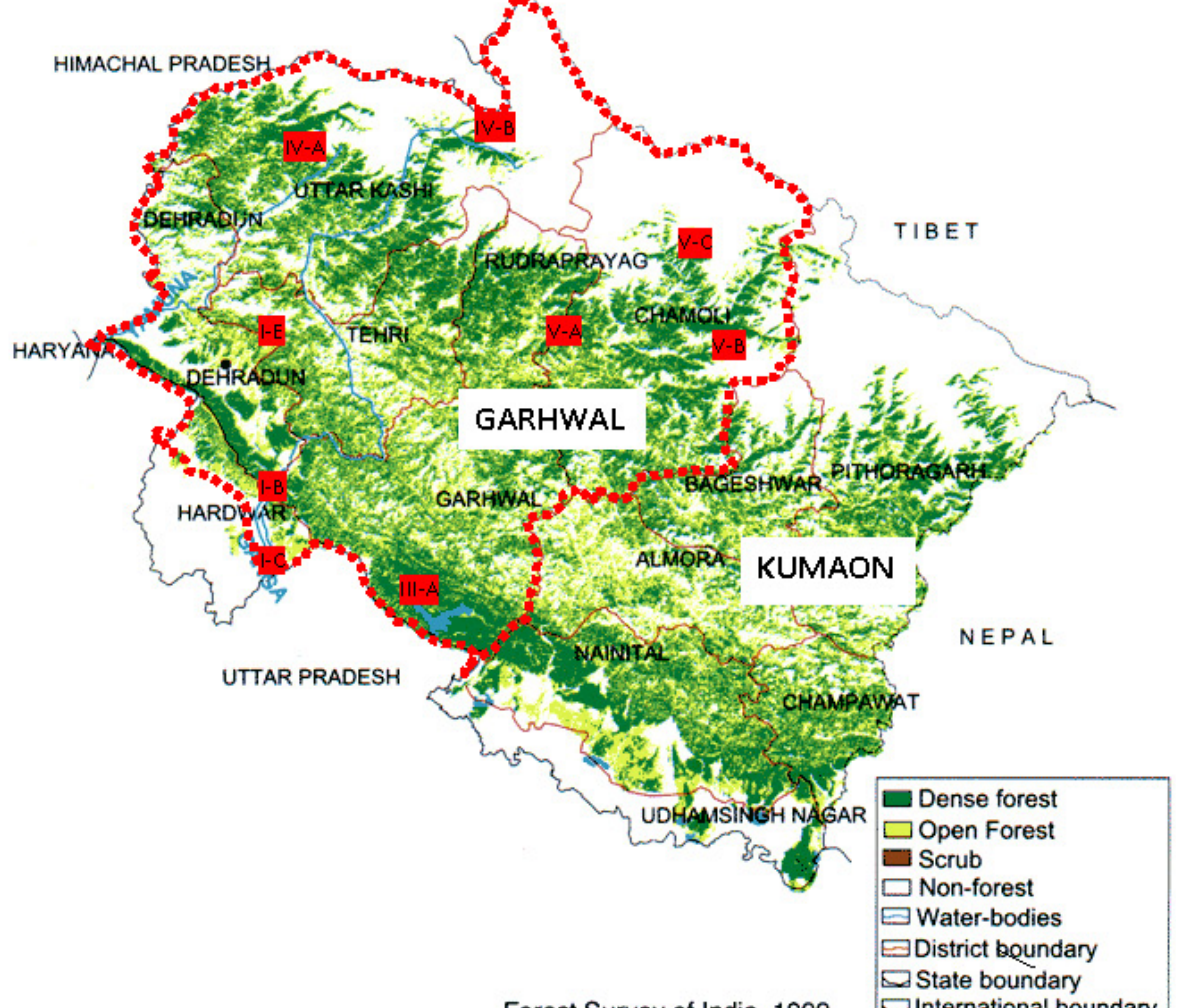
Figure 1. Map of Garhwal (encircled in red dots) showing the seven districts and locations of the protected areas as given in Table